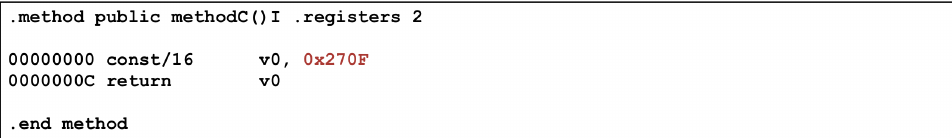
Figure 17. Disassembled MethodC with ProGuard